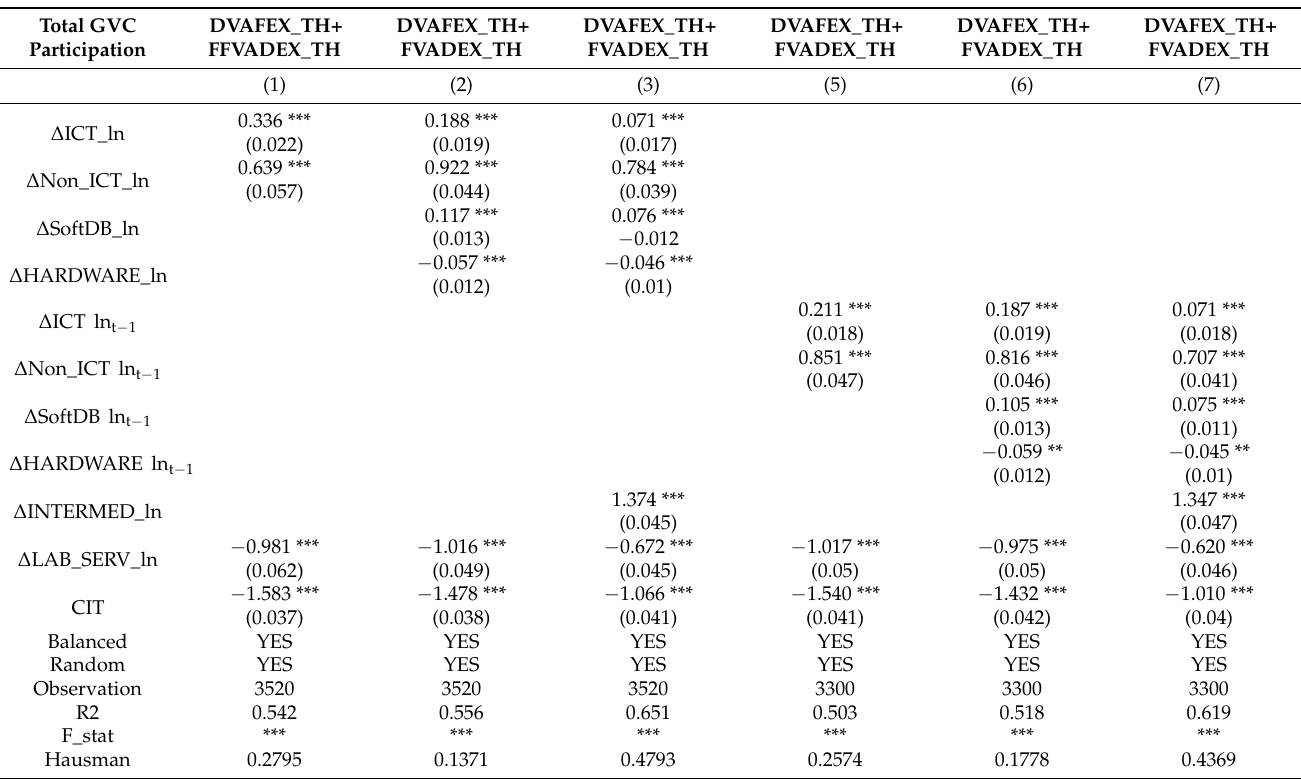
Table 3. Random effect panel regression results of the impact of ICT assets on total global value chains participation. The level of statistical significance is indicated as follows with symbols * p < 0.05, ** p < 0.01, and *** p <